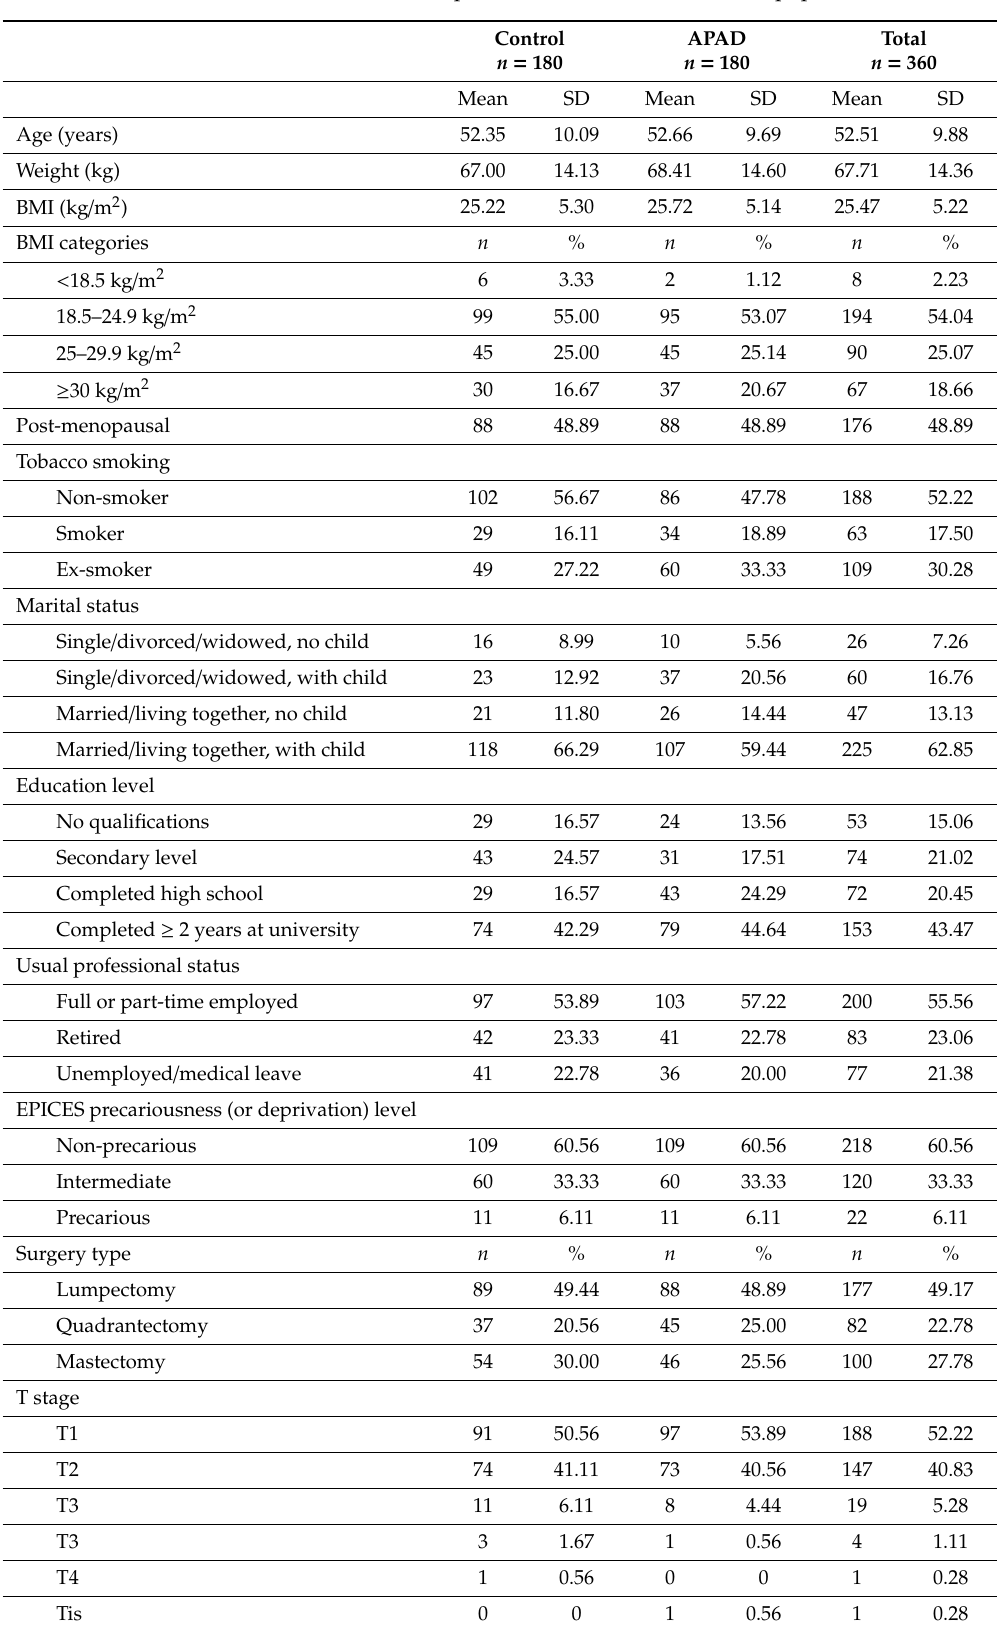
Table 1. Baseline characteristics of patients in the intention-to-treat